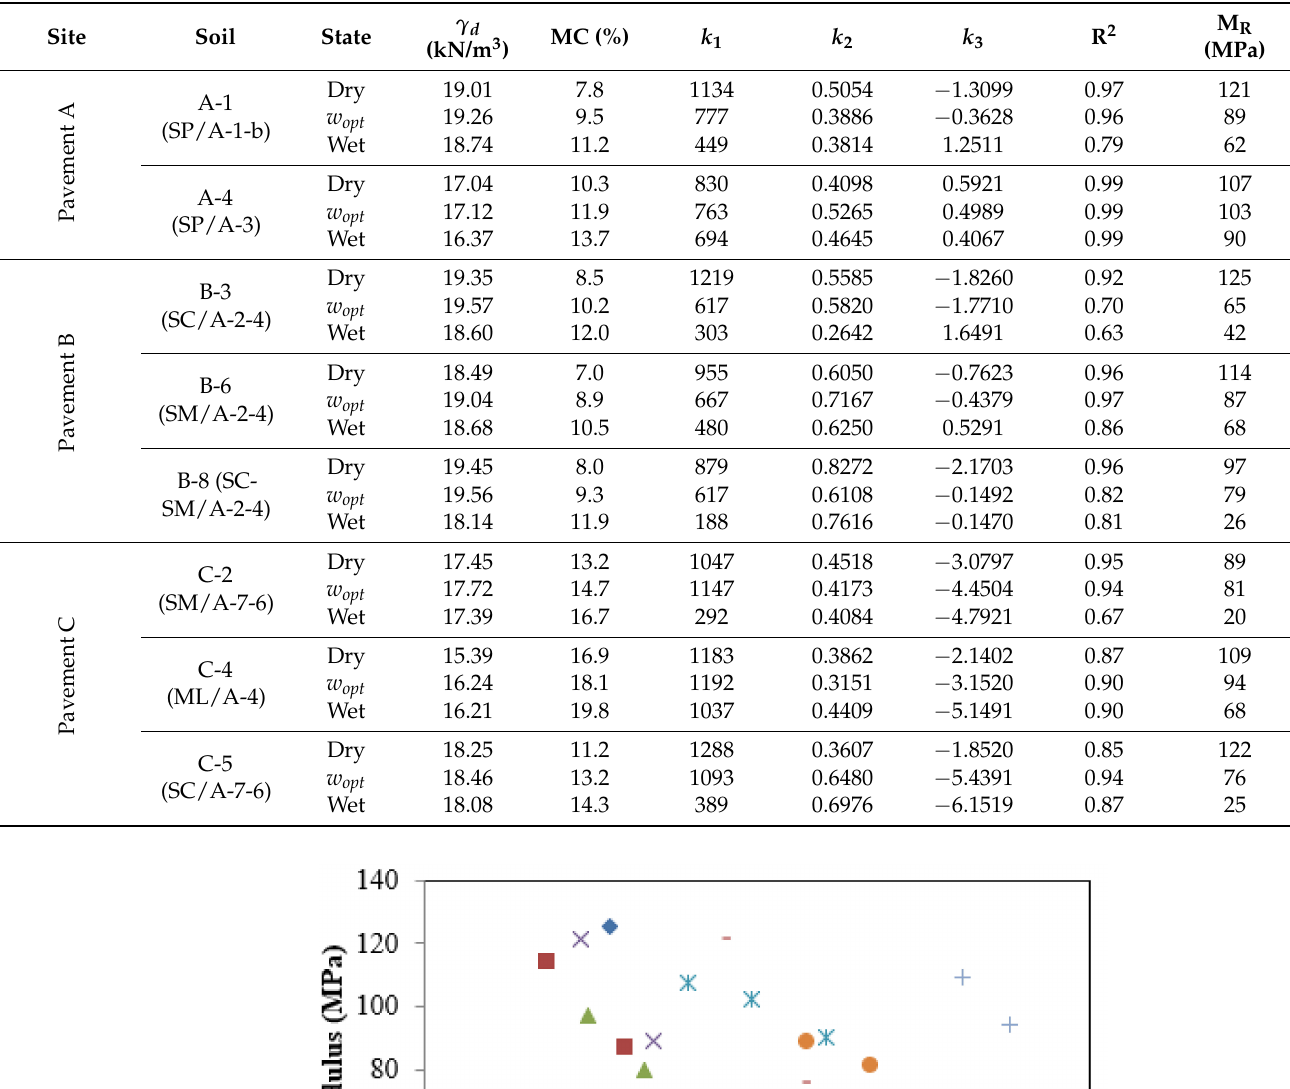
Table 3. Resilient Modulus Model Parameters.